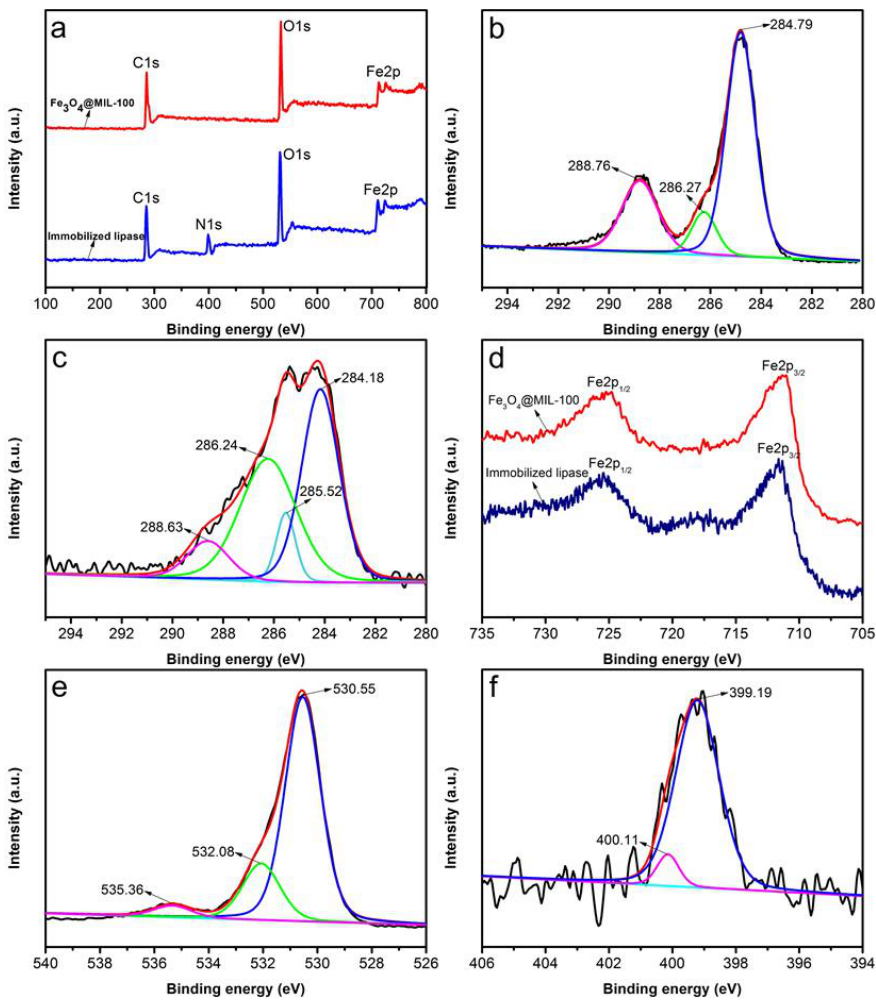
Figure 6. XPS spectra for ( a ) the survey spectra of Fe 3 O 4 @MIL-100(Fe) and the immobilized lipase; ( b ) C 1s spectra of Fe 3 O 4 @MIL-100(Fe); ( c ) C 1s spectra of the immobilized lipase; ( d ) Fe 2p spectra of Fe 3 O 4 @MIL-100(Fe) and the immobilized lipase; ( e ) O 1s spectra of the immobilized lipase; and ( f ) N 1s spectra of the immobilized lipase.